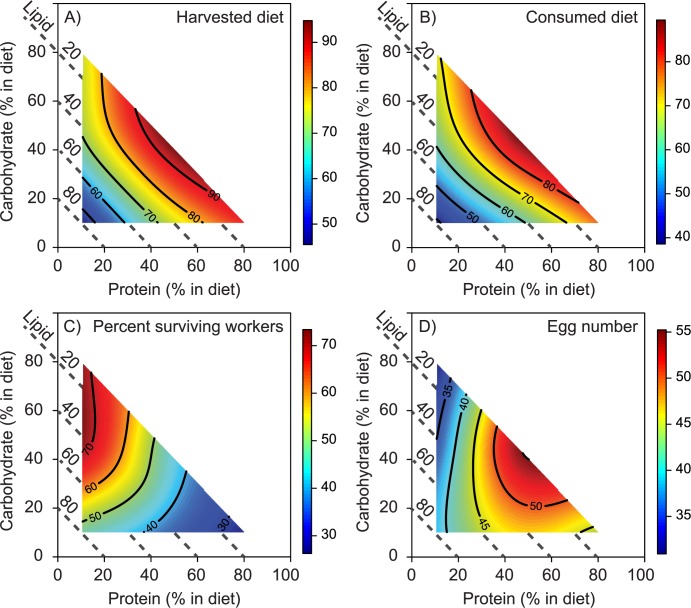
Nutritional landscapes visualize the fundamental macronutrient niche (FMN) of M. pharaonis in three dimensions (proteins, carbohydrates, and lipids; P:C:L).(A) Colonies harvested maximal amounts across a broad range of protein-biased and carbohydrate-biased diets, while avoiding lipid-biased diets. (B) Colonies consumed most of the diet they harvested regardless of the P:C:L content. (C) The survival percentage of adult workers was highest on diets with moderate to high carbohydrates, low protein and low to moderate lipids. In contrast, moderate to high amounts of protein yielded the lowest worker survival, even as carbohydrates and lipids increased. (D) Colonies produced the most eggs when colonies were confined to diets with similar levels of protein and carbohydrates and low lipid content, and the fewest eggs on all diets where protein availability was low, regardless of carbohydrate and lipid amounts. Isoclines (red areas are highest values and blue areas are lowest) indicate dry mass of diet (mg), percent worker survival, or egg numbers, with scale bars adjusted relative to the range of observed values. Landscapes comprise 7 P:C:L ratios (see
Fig 1C) and diet percentages (axis labels) indicate energy content provided by each macronutrient, with total energy content available standardized across diets (see Methods). Response surface regressions underlying colored heat maps were significant in each panel (Table 1).